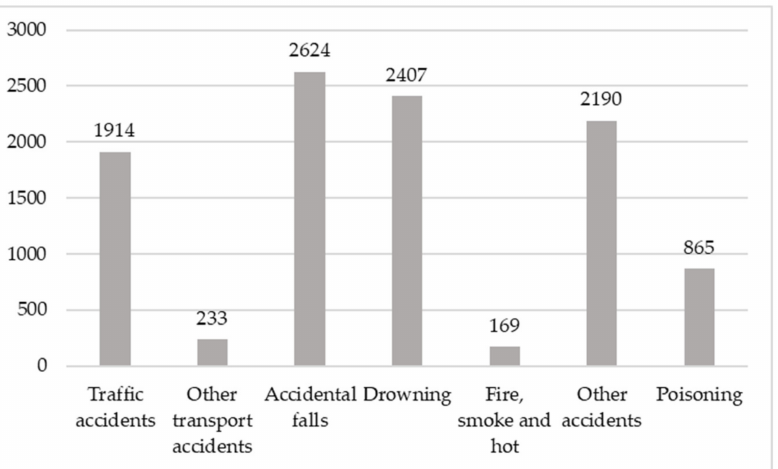
Figure 4. Average yearly number of casualties due to the most frequent accident types in Spain (based on the Spanish National Institute of Statics (INE), Death Statistics According to Cause of Death).